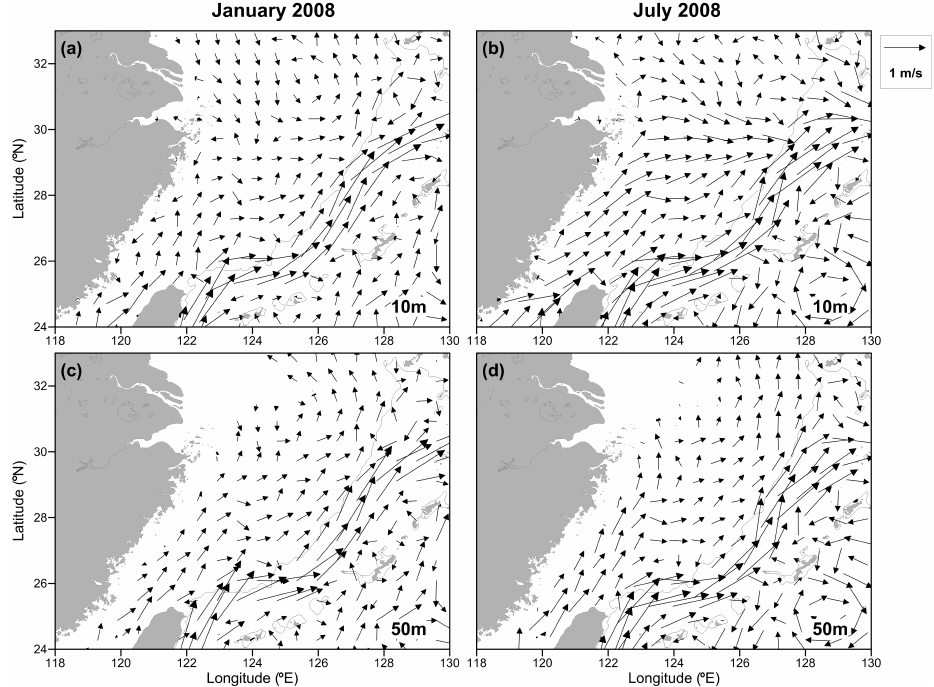
Fig. 3. Current conditions (length of arrow, current speed with a scale of 1ms − 1 ; arrow direction, current direction) at the depths of 10m ( (a) , b ) and 50m ( c , d ) in the ECS derived from the OPeNDAP ocean database, January and July 2008.